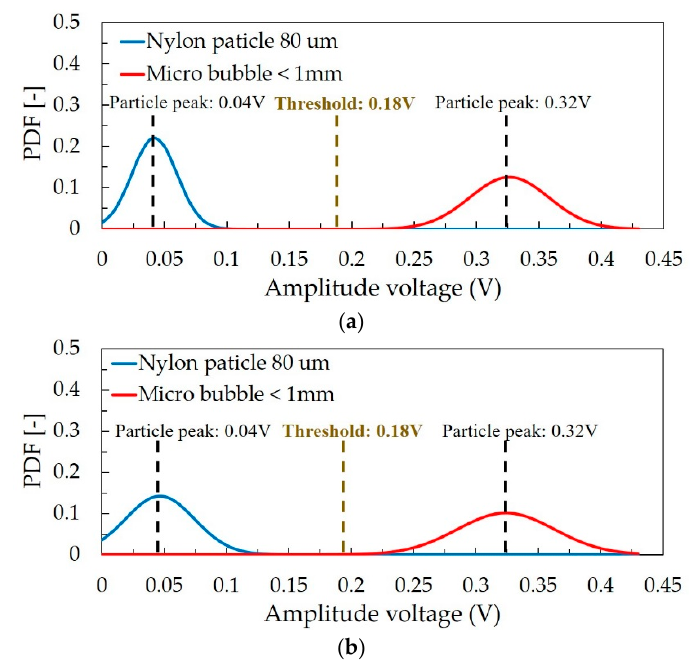
Figure 13. Doppler amplitude threshold setting on probability density function (PDF) of Doppler amplitude reflected by nylon particles 80 µ m and microbubble <1 mm; ( a ) at U L : 200 mm/s and ( b ) at U L : 300 mm/s.